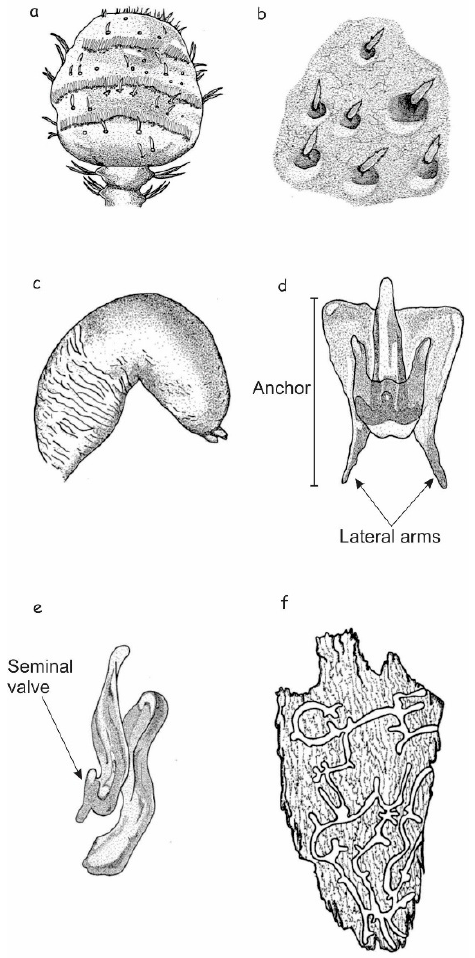
Figure 8. Dendroctonus brevicomis : ( a ) Antennal club, ( b ) elytral sculpturing and setae, ( c ) spermatheca, ( d , e ) seminal rod in dorsal and lateral view, ( f ) parental tunnels in host bark.